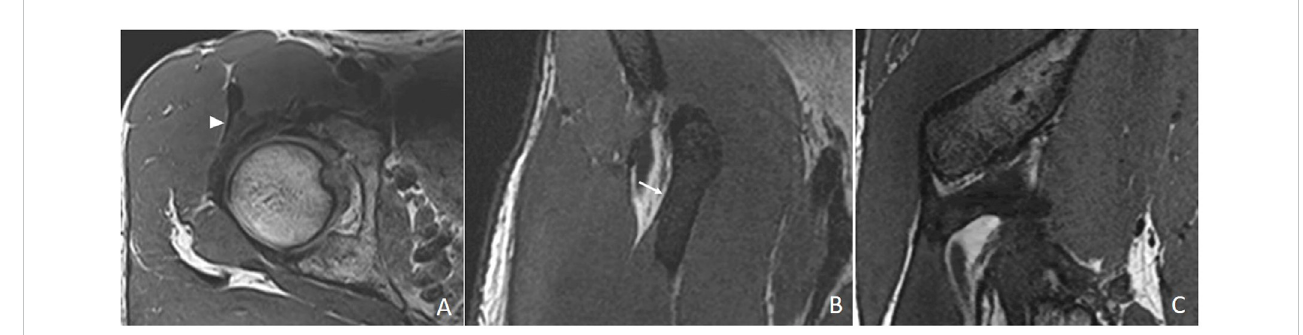
FIGURE 2 Multiplanar reconstruction. (A) Chosen axial 3D proton density section to orientate the sagittal plane following the lateral margin of the anterior portion oftheindirecttendon(whitearrowhead). (B) Chosencoronal3Dprotondensitysectiontoorientatethesagittalplanefollowingthelateralmarginofthedirect tendon (white arrow). (C) Resulting oblique sagittal plane.